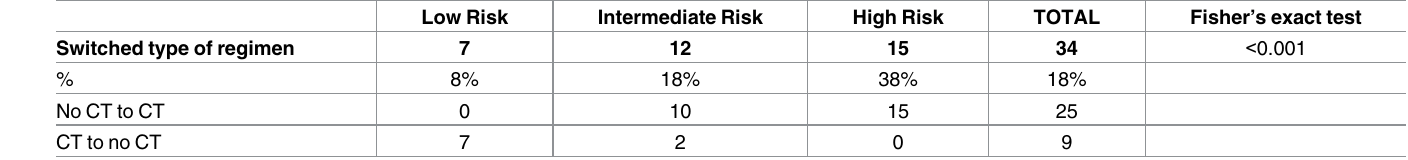
Table 4. Adjuvant treatment recommendation pre- and post-Prosigna test results, by Prosigna test risk category.